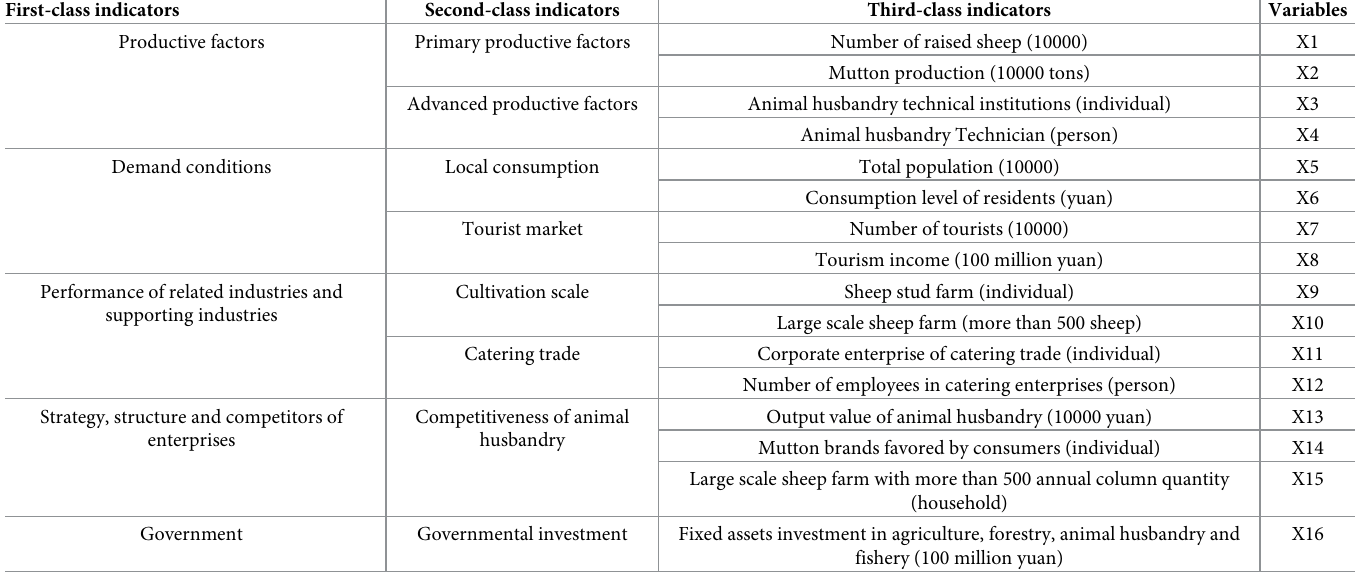
Table 1. The evaluation index of mutton industry